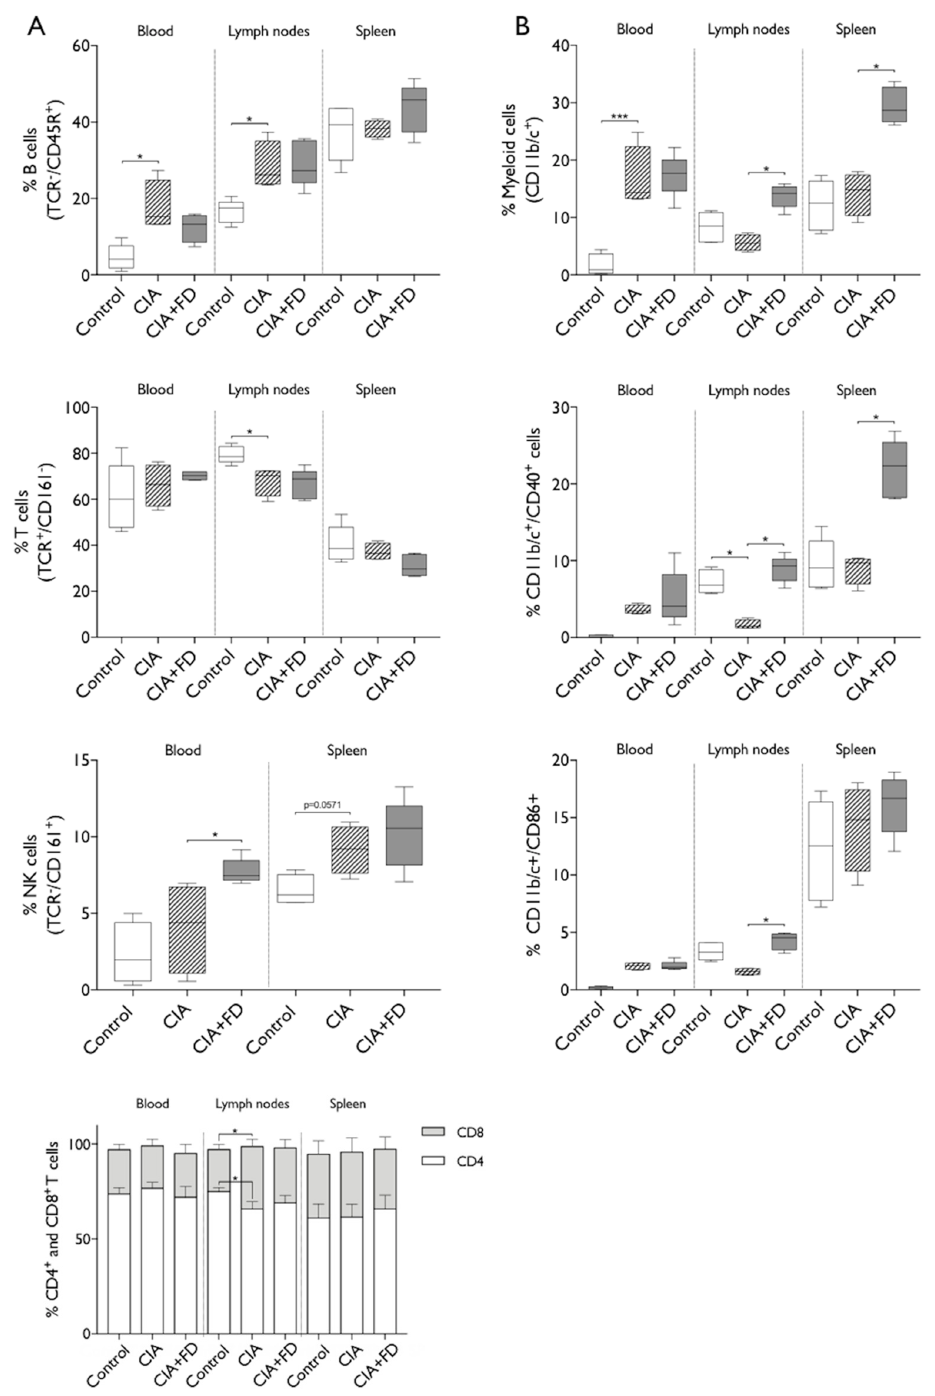
Figure 3. CIA and CIA+FD lead to alterations in systemic immune cell proportions. The percentages of lymphoid and myeloid populations at systemic level were analyzed in blood, draining lymph nodes and spleen of control, CIA, and CIA+FD animals, by multicolor flow cytometry. ( A ) Percentage of main lymphoid populations: B cells (TCR − /CD45 + ), T cells (TCR + /CD161 − ), NK cells (TCR − /CD161 + ), and CD4 (TCR + /CD4 + ) and CD8 (TCR + /CD8 + ) T cells. ( B ) Myeloid cells (CD11b/c + ), and their activation status as determined by co-expression of the co-stimulatory markers CD40 and CD86. Box plots represent min-to-max distribution of n = 4 to 5 animals per group. * p < 0.05, ** p < 0.01, *** p < 0.001 determined by Kruskal–Wallis test and Dunn’s multiple comparisons test.